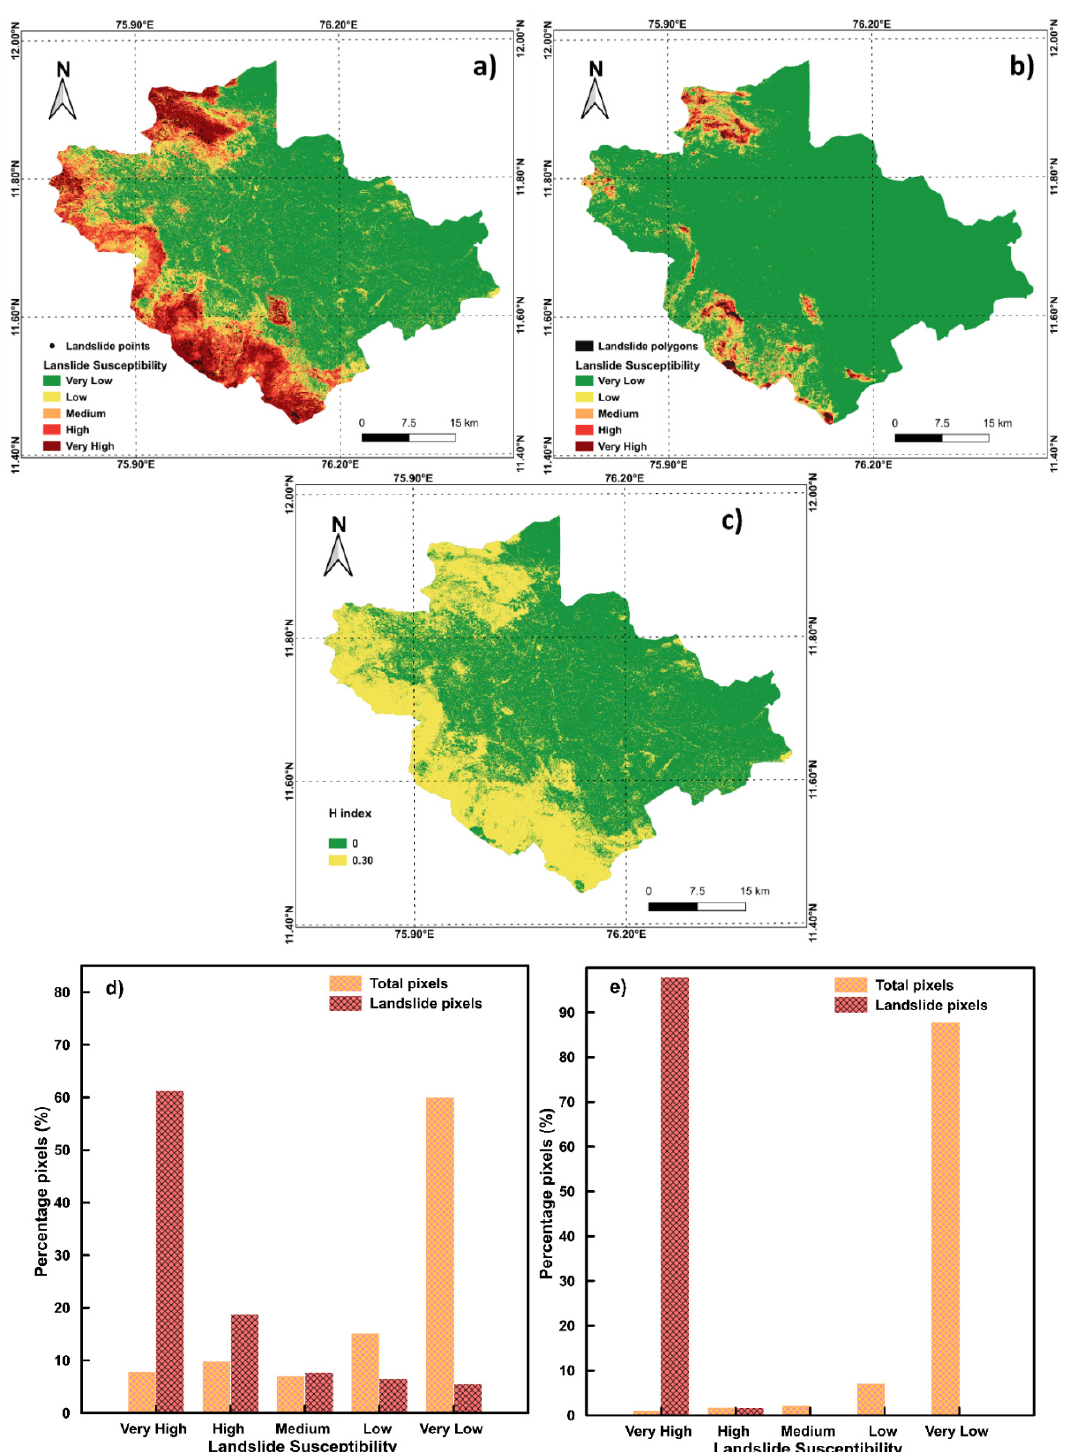
Figure 10. Details of landslide susceptibility map prepared using RF algorithm: ( a ) using point data, ( b ) using polygon data, ( c ) H-index plot, ( d ) percentage distribution of pixels using point data, and ( e ) percentage distribution of pixels using polygon data.